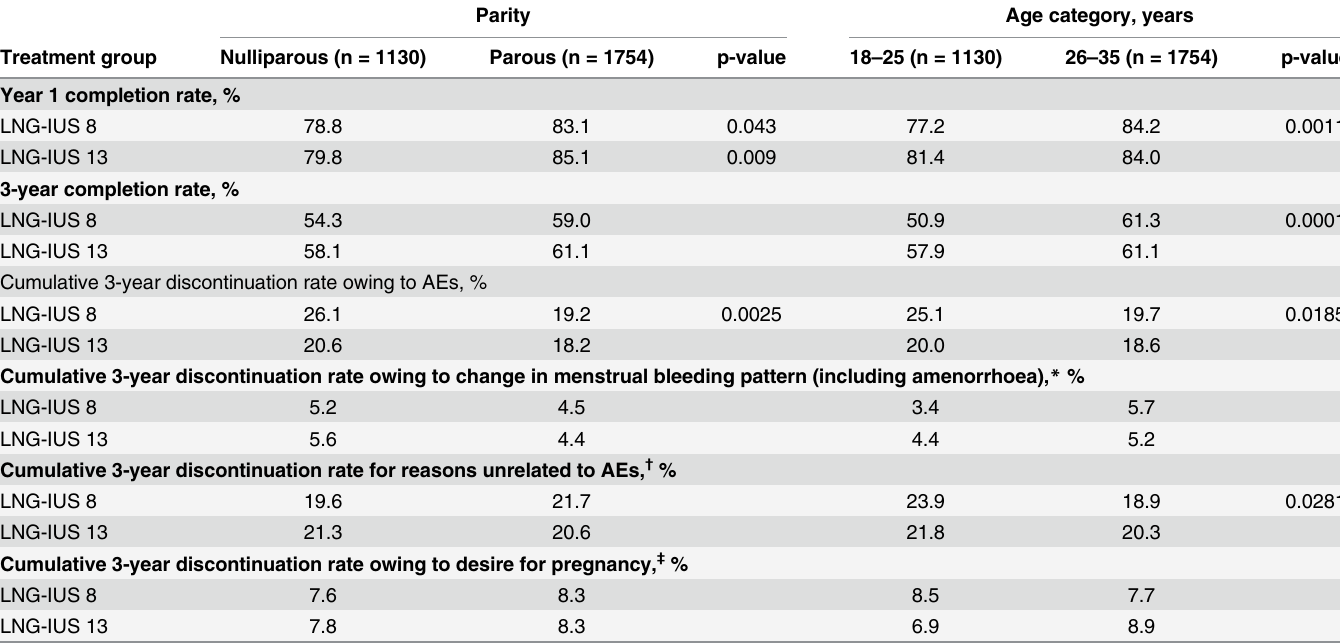
Table 6. Completion and Discontinuation Rates According to Parity Status and Age.